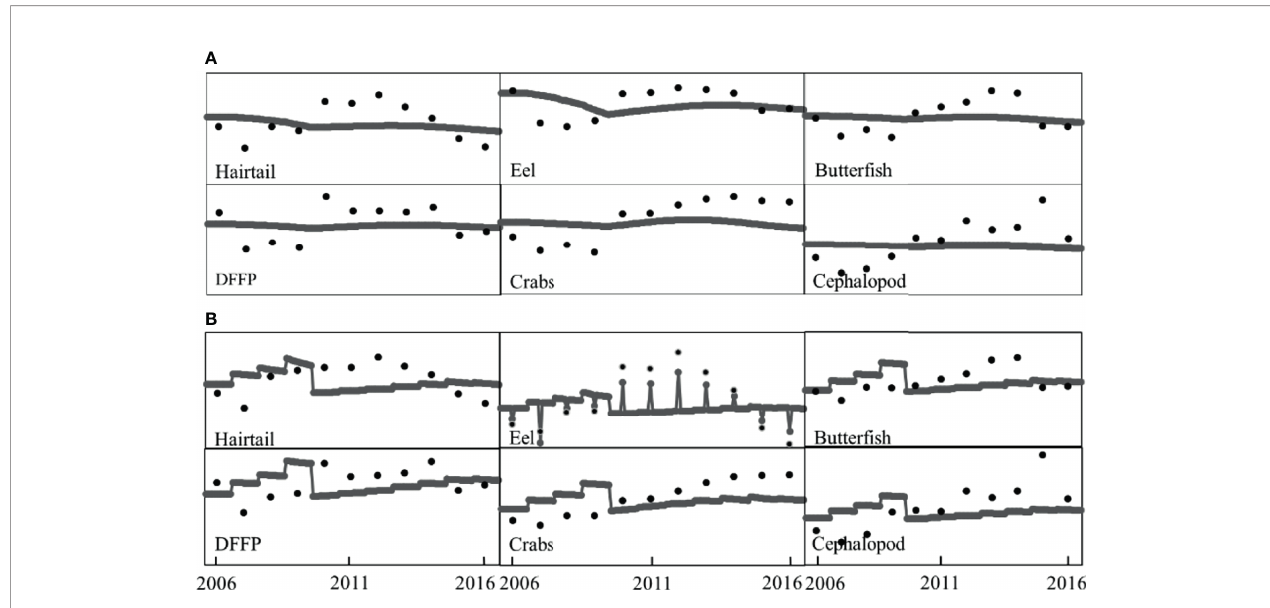
FIGURE 3 | The best- fi tted values of time series data from the start year 2006 to the end year 2016 in CPUE (A) and landings (B) of 6 functional groups for dynamic